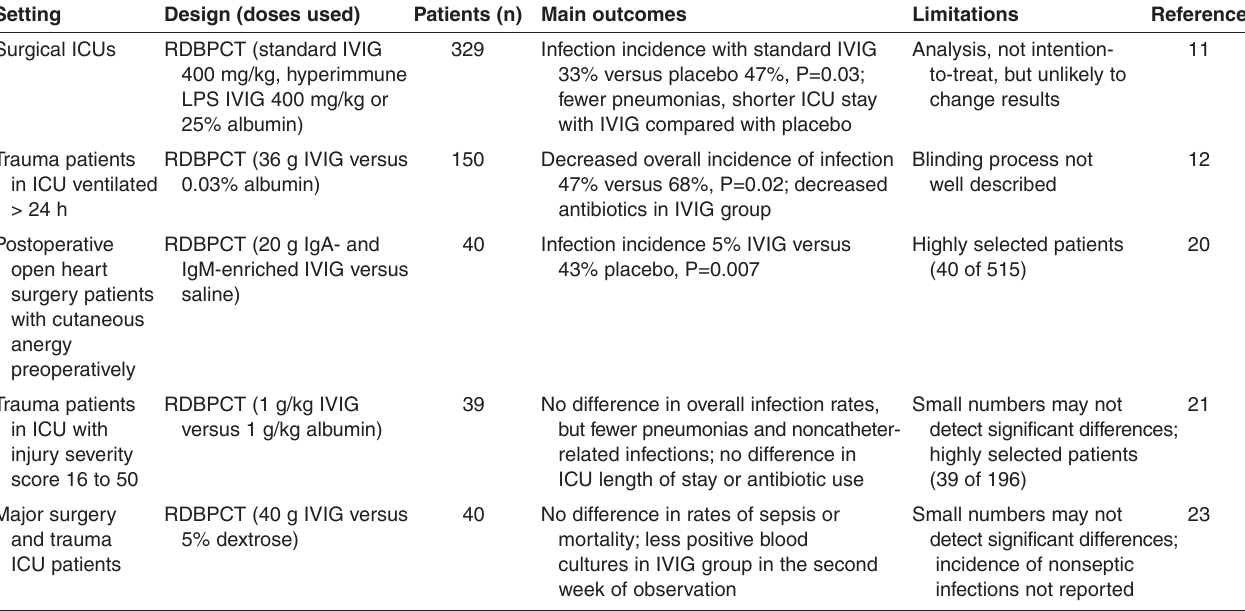
Randomized, controlled trials of intravenous immunoglobulin (IVIG) for the prophylaxis of infection in critically ill adults Setting Design (doses